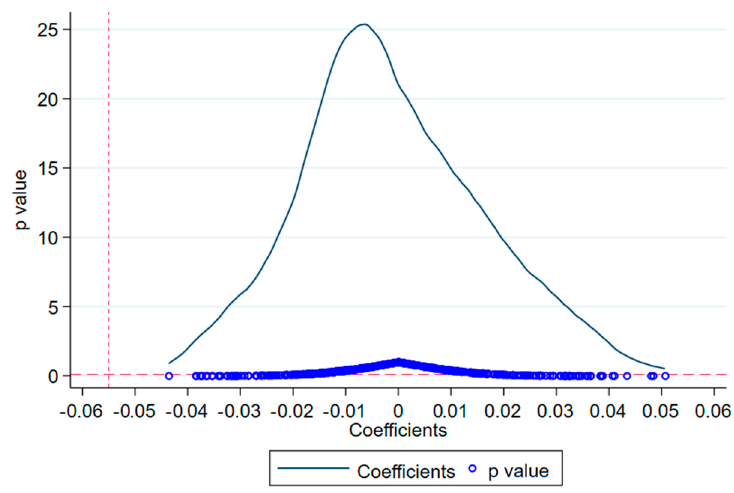
Figure 4. Placebo test results for random assignment of treatment groups.